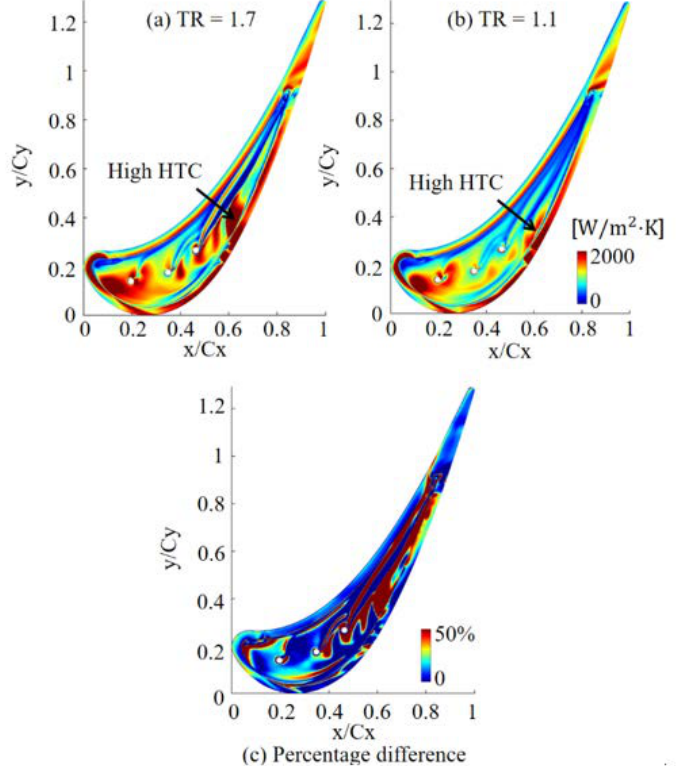
Figure 9. Heat transfer coefficient distribution and percentage error of the cooled squealer tip: ( a ) HTC distribution at TR = 1.7, ( b ) HTC distribution at TR = 1.1, ( c ) HTC difference for different